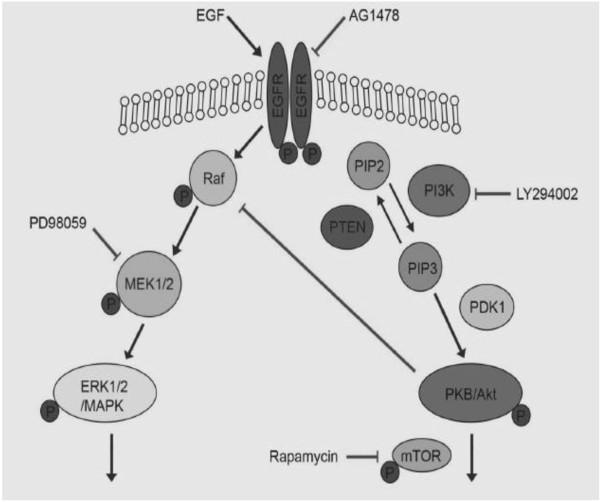
Components of the EGFR pathways and their specific inhibitors. EGFR (Epidermal growth factor receptor), PIP2, PIP3 (Phosphatidylinositol-4,5-bisphosphate (PIP2), Phosphatidylinositol 3,4,5-trisphosphate (PIP3), MAPK/ERK (mitogen activited proteinkinase), mTOR/FRAP (Mammalian target of rapamycin), PI3K (Phosphatidylinositol-3'-Kinase), PKB/Akt (Proteinkinase B), PTEN (Phosphatase and tensin homologue deleted on chromosome ten).